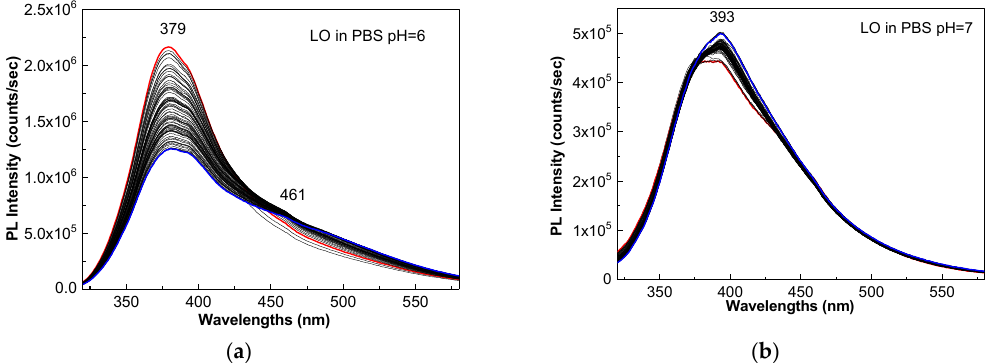
Figure 4. PL spectra of the LO drug in PBS having pH equal to 6 ( a ) and 7 ( b ), when the excitation wavelength is 300 nm. The red, black and blue curves correspond to the PL spectra of samples before, in the intermediate state and after 187 min. of exposure to UV light.